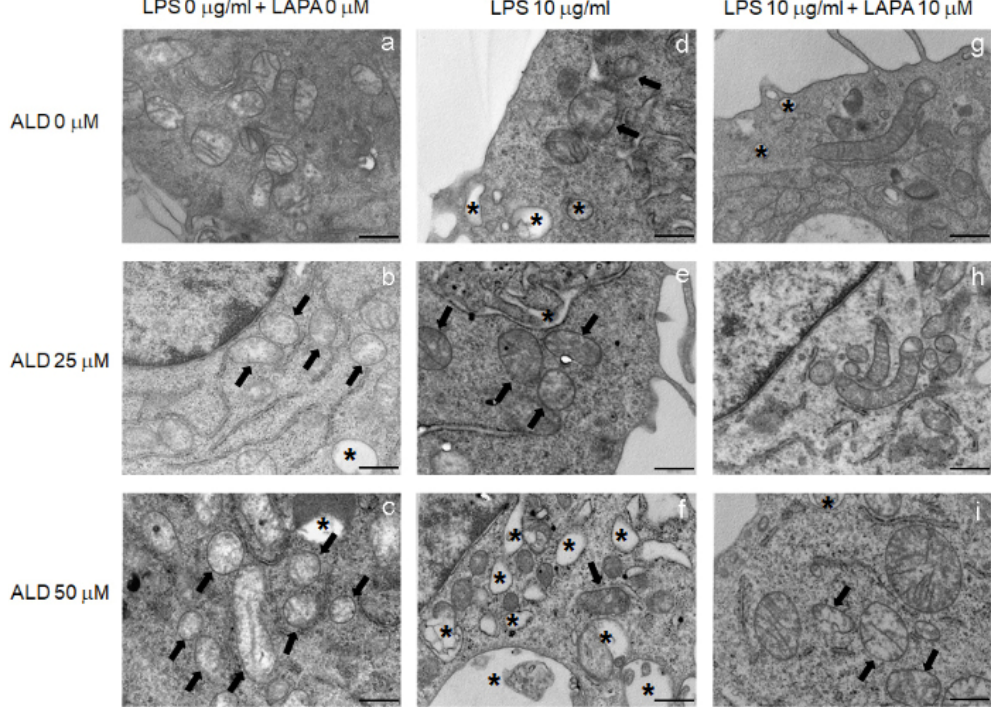
Figure 6. Morphological analysis of RAW 264.7 cells treated with ALD 25 µ M or 50 µ M plus 10 µ g/mL LPS, with or without 10 µ M Lapaquistat (LAPA). The ultrastructure of the cells was detected by transmission electron microscope (TEM). ( a – i ) Representative TEM images of RAW 264.7 cells treated as indicated in the figure labels, 25,000 × magnification. Black arrows: swollen mitochondria. Asterisks: cytoplasmic vacuolations. Scale bars: 500 nm.